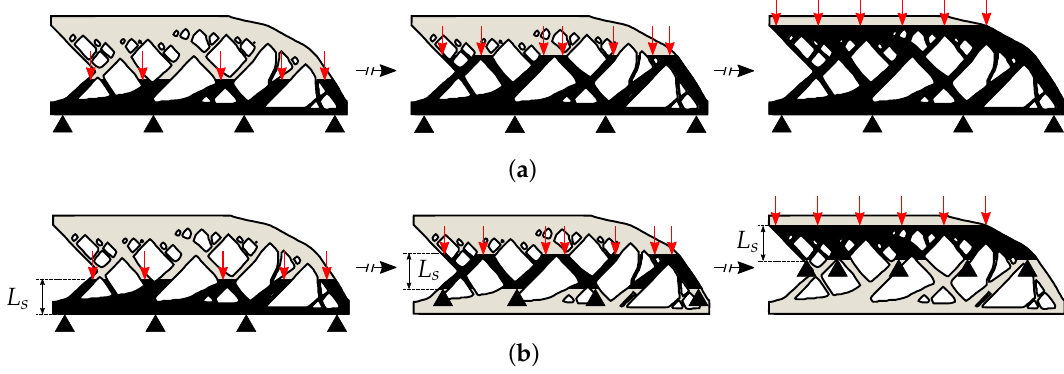
Figure 9. ( a ) Temporal decoupling: each new layer is assumed to be added at initial temperature T 0 and peak temperatures at the end of the heating step are used for preparing the hotspot map. This enables parallel simulation of all the layer additions providing computational gains. In this model, no data is shared between the simulations which is indicated by the horizontal broken arrows. ( b ) Spatial decoupling: only a relevant sub-geometry is considered for transient thermal analysis. This simplification is applied in addition to the temporal decoupling simplification introduced in ( a ).